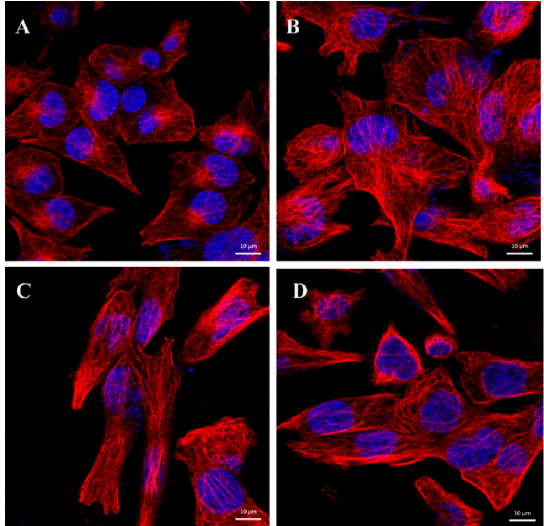
Figure 9. CA affects the dynamics of microtubules in A375 cells. Confocal laser scanning microscopy. Microtubules (red) stained by indirect immunofluorescence and nuclei (DAPI staining, blue) after 24 h treatment with CA at concentrations ( B ) 20, ( C ) 30 and ( D ) 40 μ g/mL. The regular network of microtubules was observed in ( A ) control DMSO treated cells, while upon CA treatment thicker microtubule bundles and larger nuclei in enlarged cells were apparent ( B – D ). Bars = 10 μ m.